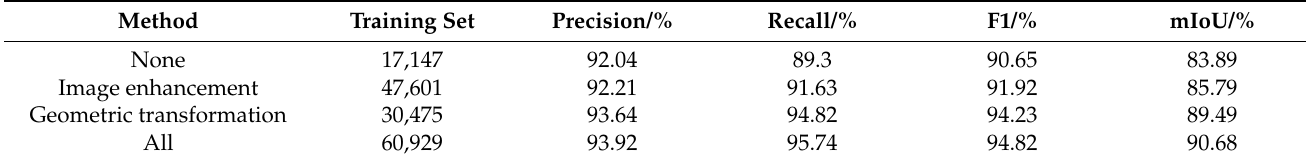
Table 6. Results of different data augmentation techniques on the test set.